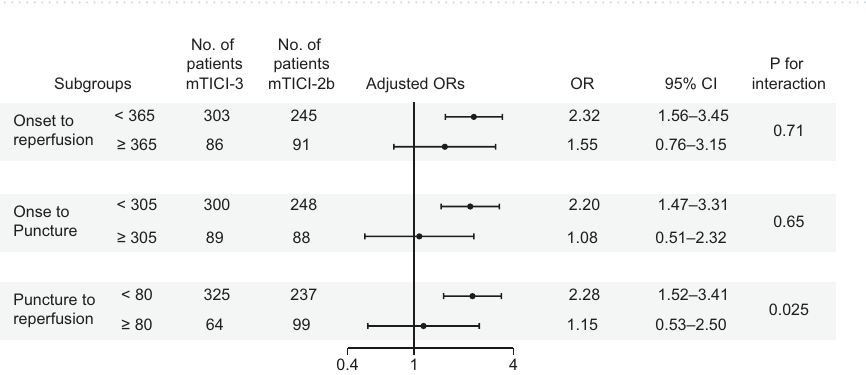
The ORs for excellent outcome are shown in Supplementary Fig. S2. In the subgroup of onset-to-reperfusion time < 365, onset-to-puncture time < 305, and puncture-to-reperfusion time < 80, excellent outcome was observed significantly more often in patients with mTICI-3 than in those with mTICI-2b (adjusted OR, 2.35; 95% CI, 1.55–3.55; adjusted OR, 2.13; 95% CI, 1.39–3.26; and adjusted OR, 2.35; 95% CI, 1.53–3.61, respectively). On the other hand, there was no significant association between mTICI score and excellent outcome in the sub- group of puncture-to-reperfusion time ≥ 80 (adjusted OR, 1.17; 95% CI, 0.46–3.00), and there was a marginal heterogeneity in the effect of mTICI-3 reperfusion across the puncture-to-reperfusion time subgroups (P for interaction = 0.073). Changes in the probability of favorable outcome with time course in continuous variables stratified by mTICI score are shown in Fig. 4. As a continuous variable, none of the onset-to-reperfusion time, onset-to-puncture time, or puncture-to-reperfusion time significantly modified the effect of complete reperfusion (P for interac- tion = 0.77, 0.70, 0.25, respectively). Changes in the probability of excellent outcome with time course in continu- ous variables stratified by mTICI score are shown in Supplementary Fig. S3. As a continuous variable, none of the time course variables significantly modified the effect of complete reperfusion.